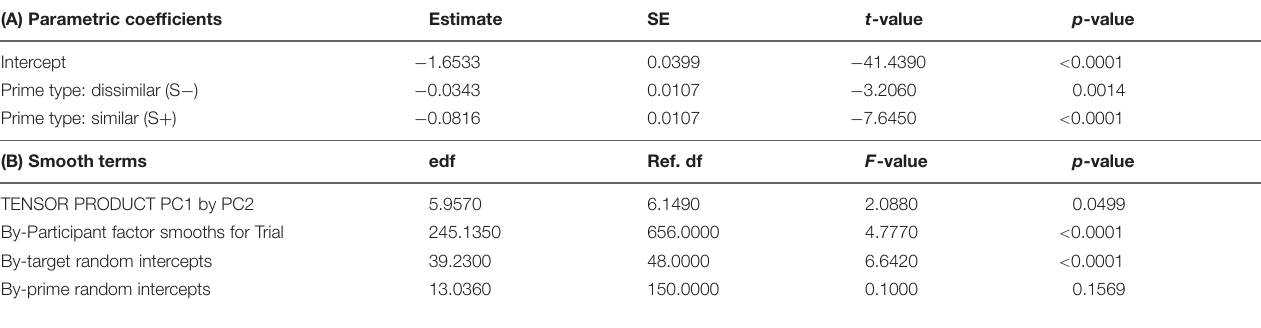
cant ( F = 4.777, p < 0.0001). Figure 9 plots colored curves,